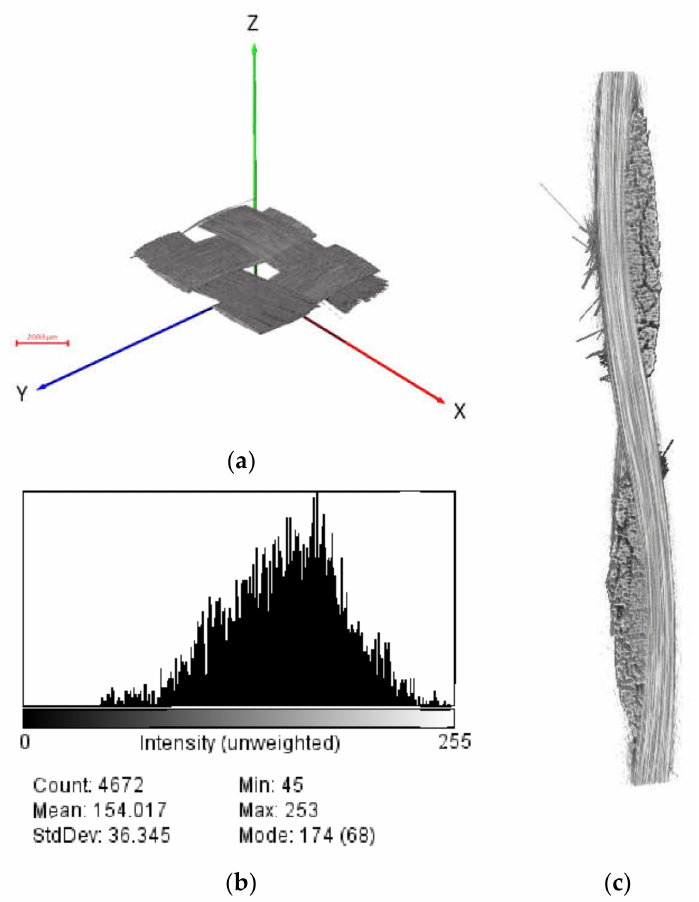
Figure 7. ( a ) Three-dimensional visualization of dry woven fabric in Avizo 9.0; ( b ) Corresponding histogram for the cross-section shown in ( c ). The thresholding range of 125–174 was used to represent carbon fibers; ( c ) a 2D slice from the cross